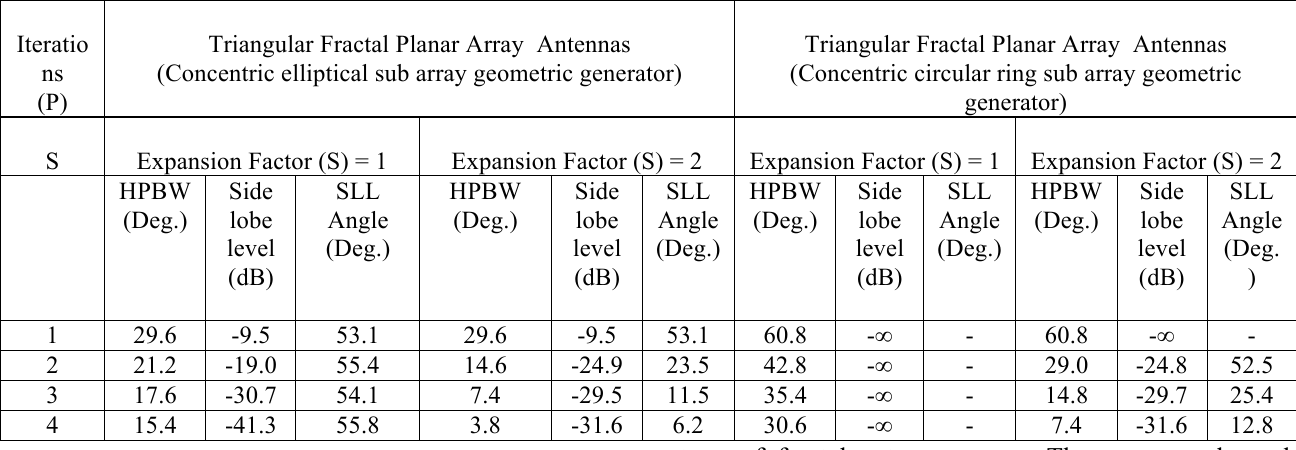
Table .II. Comparison of SLL, HPBW, SLL Angle of both linear fractal arrays generated with concentric elliptical and circular sub array generators for expansion factors S=1 and 2 up to four